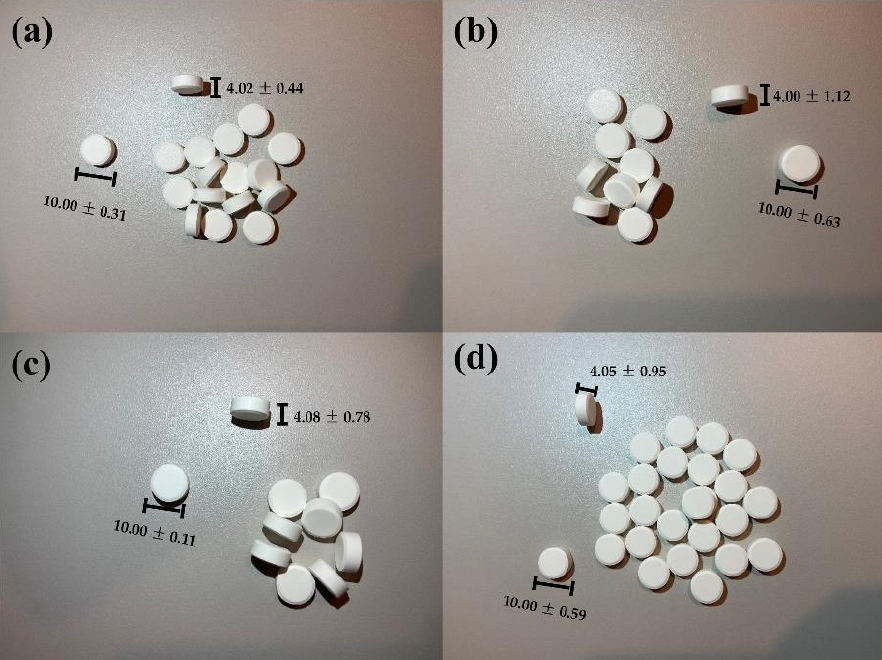
Figure 10. The general appearance of the orodispersible tablet formulations of AML-HP- β -CD: ( a ) F7, ( b ) F8; AML-Me- β -CD: ( c ) F9, ( d ) F10 (F7 is F1 with 30 kN; F8 is F1 with 60 kN; F9 is F4 with 30 kN; F10 is F4 with 60 kN). Table 5. Quality characteristics of the orally dispersible tablets (AML-HP- β -CD: F7 is F1 with 30 kN and F8 is F1 with 60 kN; AML-Me- β -CD: F9 is F4 with 30 kN and F10 is F4 with 60 kN).